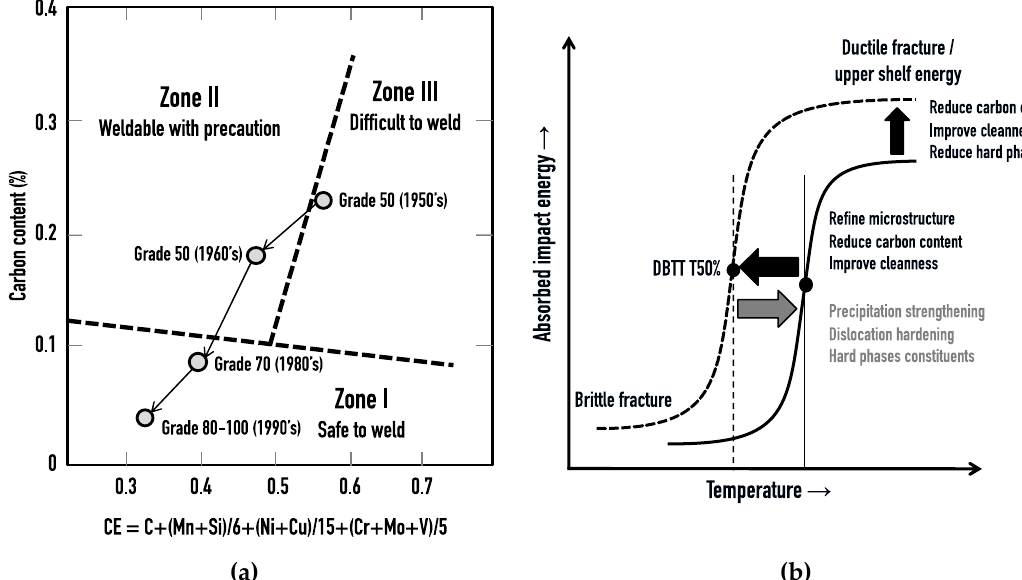
Figure 1. Design criteria for weldable high strength steels: ( a ) The Graville diagram classifying weldability of steels and historical evolution of chemical composition represented by the carbon equivalent (CE) in high strength steels; ( b ) ductile-to-brittle transition (DBTT) behavior and criteria influencing the toughness behavior in steel.